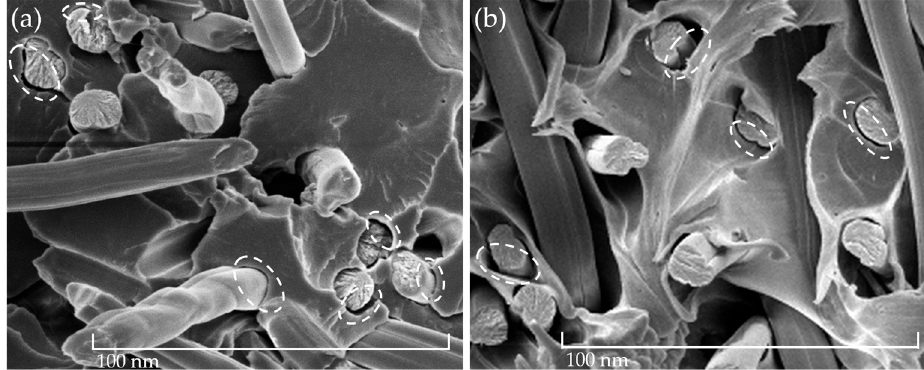
Figure 6. Detailed view of fiber–matrix debonding of PA5.10 RCF T504 ( a ) and W504 ( b ).